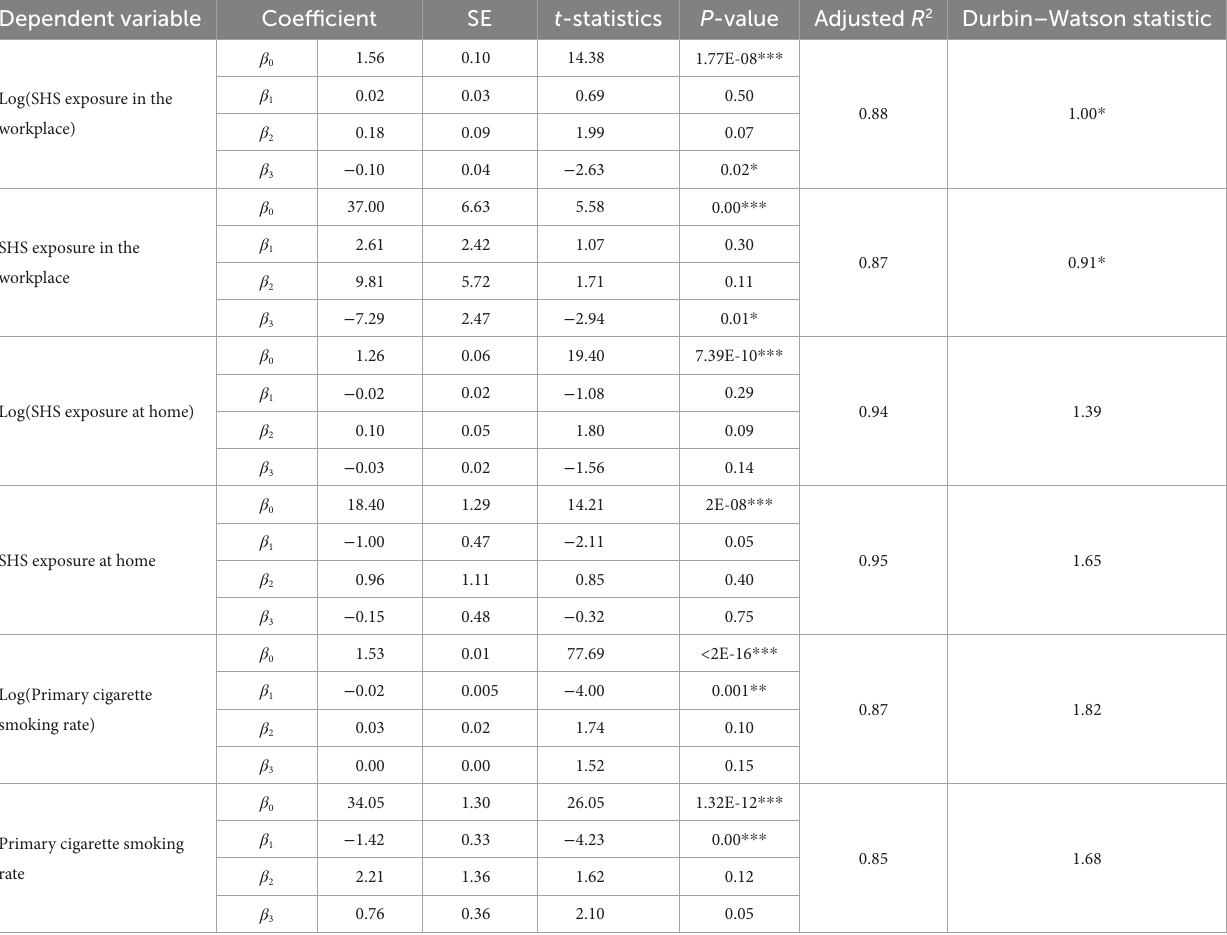
TABLE 1 Changes in secondhand smoke (SHS) exposure before and after the implementation of smoke-free policies. Dependent variable